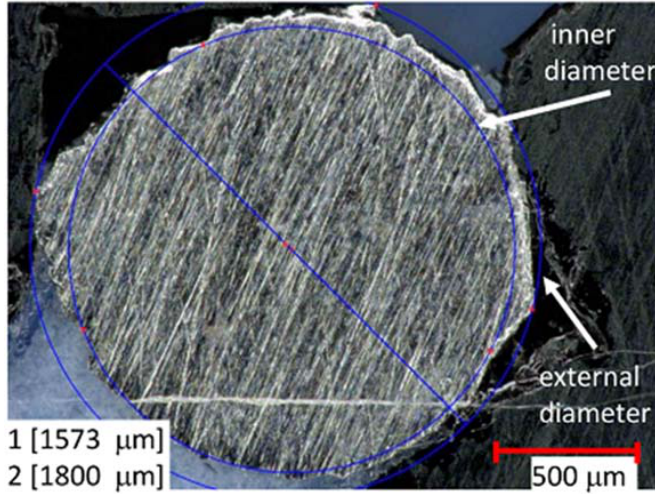
Figure 5. Sample of cross section area and the measured diameter inside the cross section area as inner diameter as well as the external diameter. In this picture is seen a 45° oriented SLM